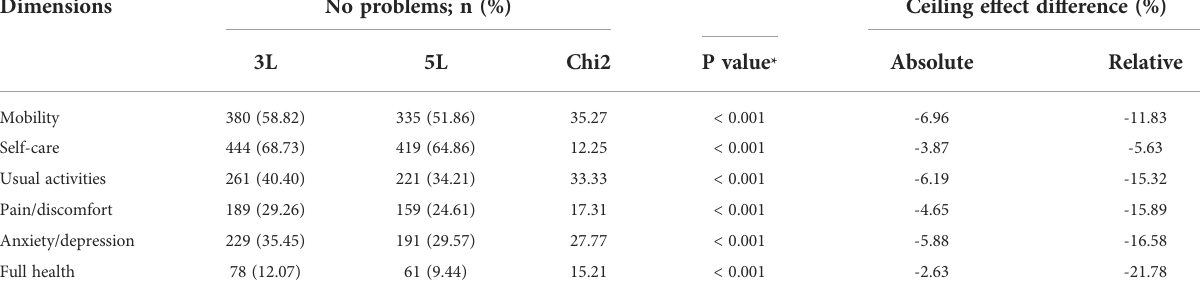
TABLE 2 Proportion of ‘‘ no problems ’’ and ceiling effects difference between 3L and 5L. Dimensions